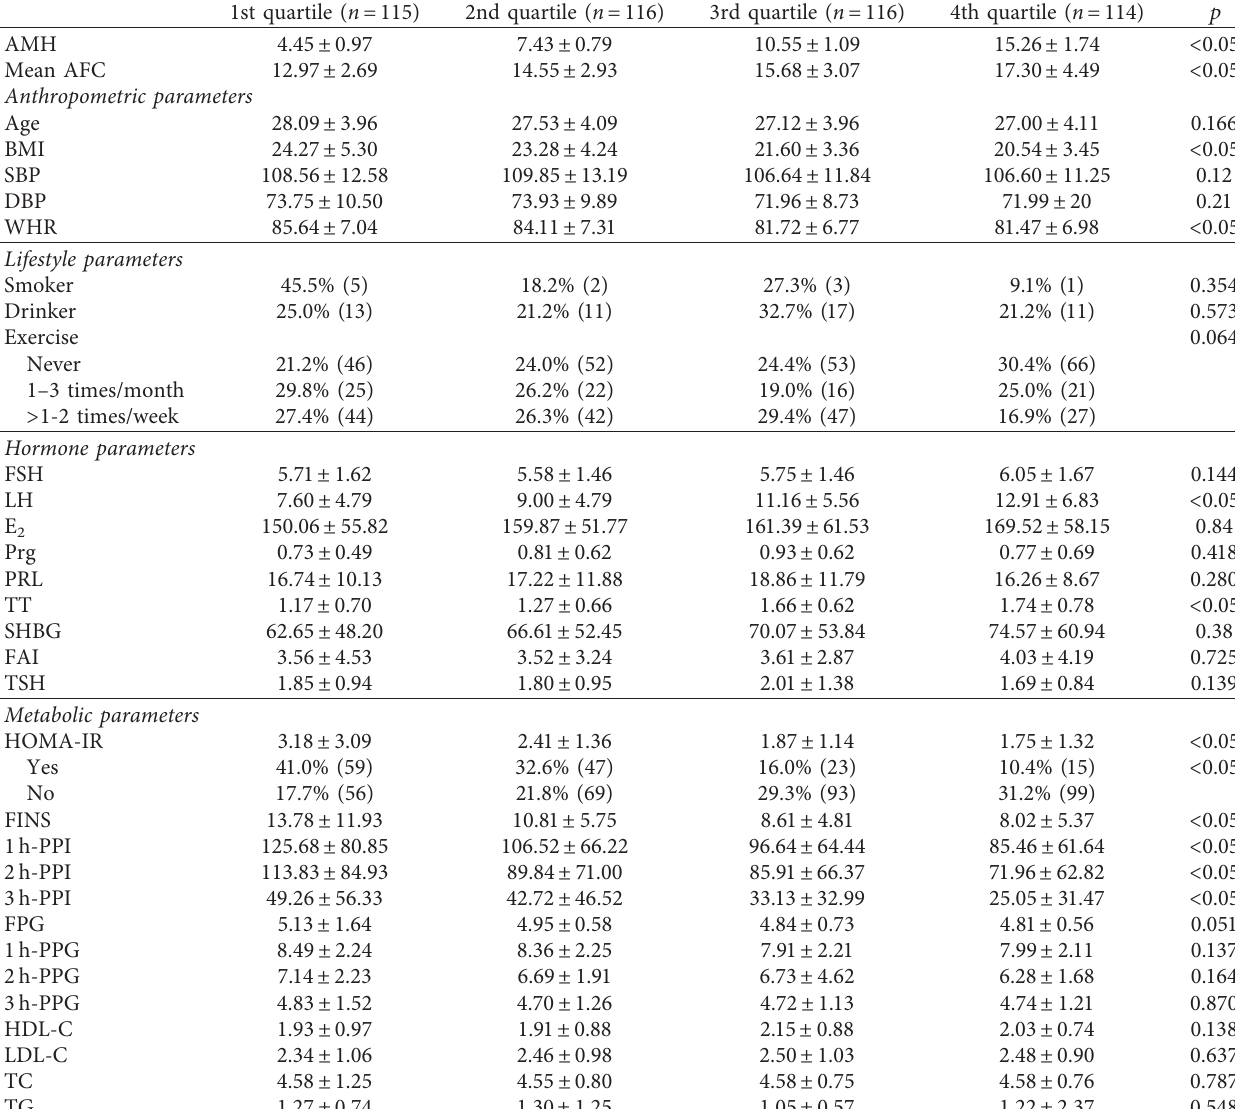
Table 1: General demographic and metabolic characteristics of the participants in the four quartiles of